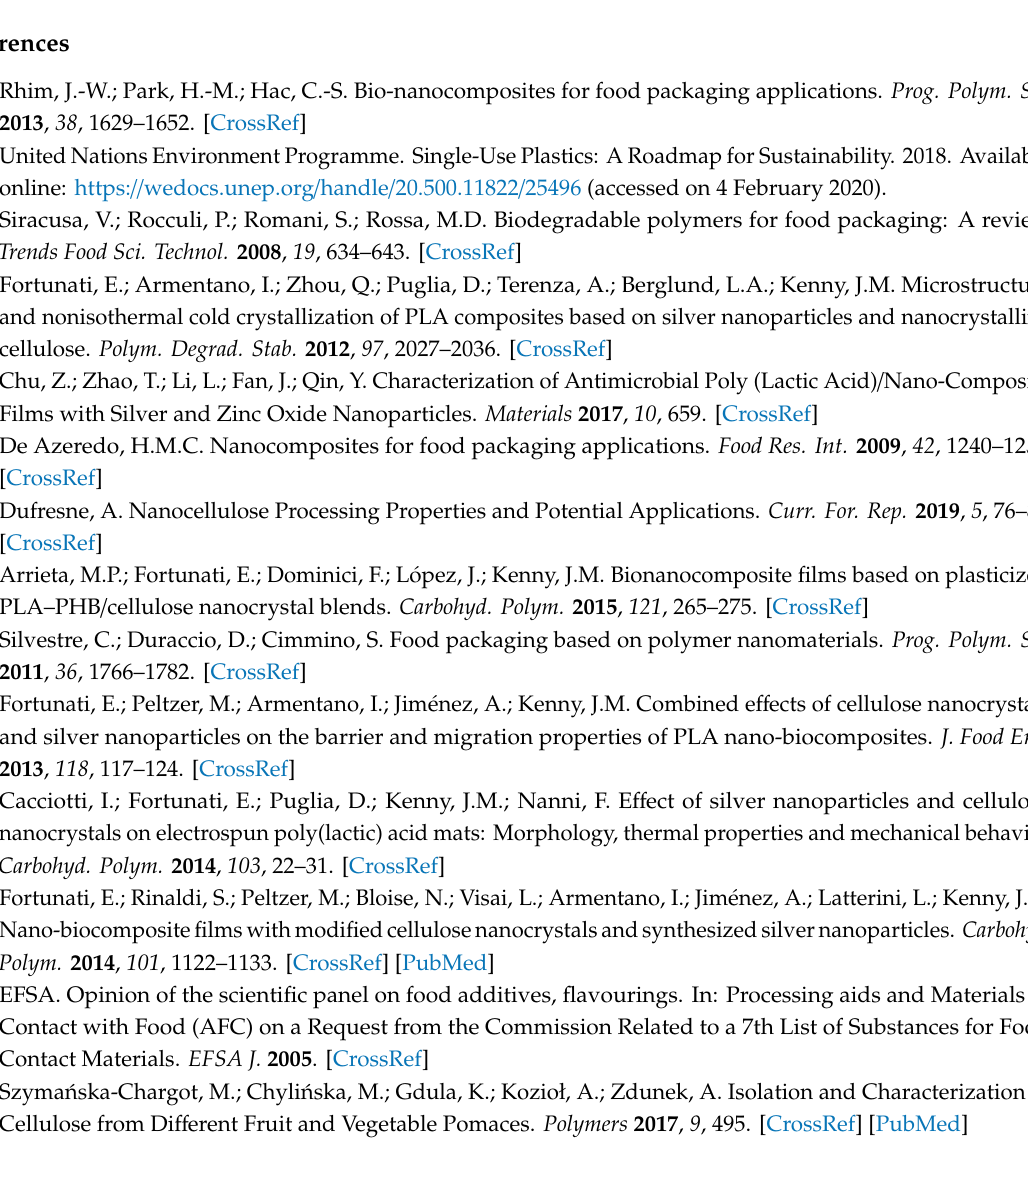
Figure S1: Photo of PLA and nanocellulose modified with silver nanoparticles composites. The ratio PLA:CCNF is marked on the pictures, Table S1: The pre-culturing conditions for tested bacterial